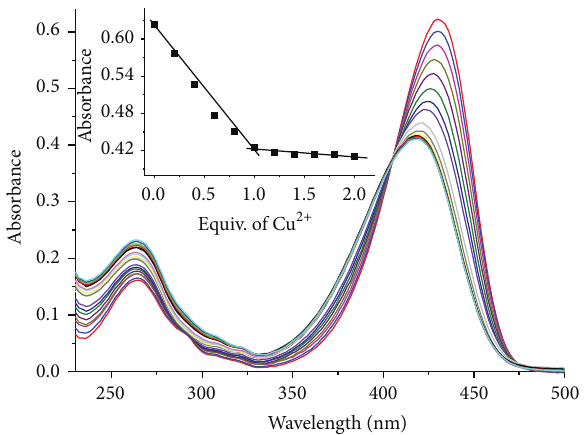
Figure 1: UV-Vis absorption responses of C -GGH (10 𝜇 mol/L) upon the addition of different concentrations of Cu 2+ (0–2equiv.) in HEPES buffer aqueous solution (10mmol/L, pH 10.0). Inset: the corresponding changes of absorption intensity of C -GGH at 430 nm in the presence of different concentrations of Cu 2+